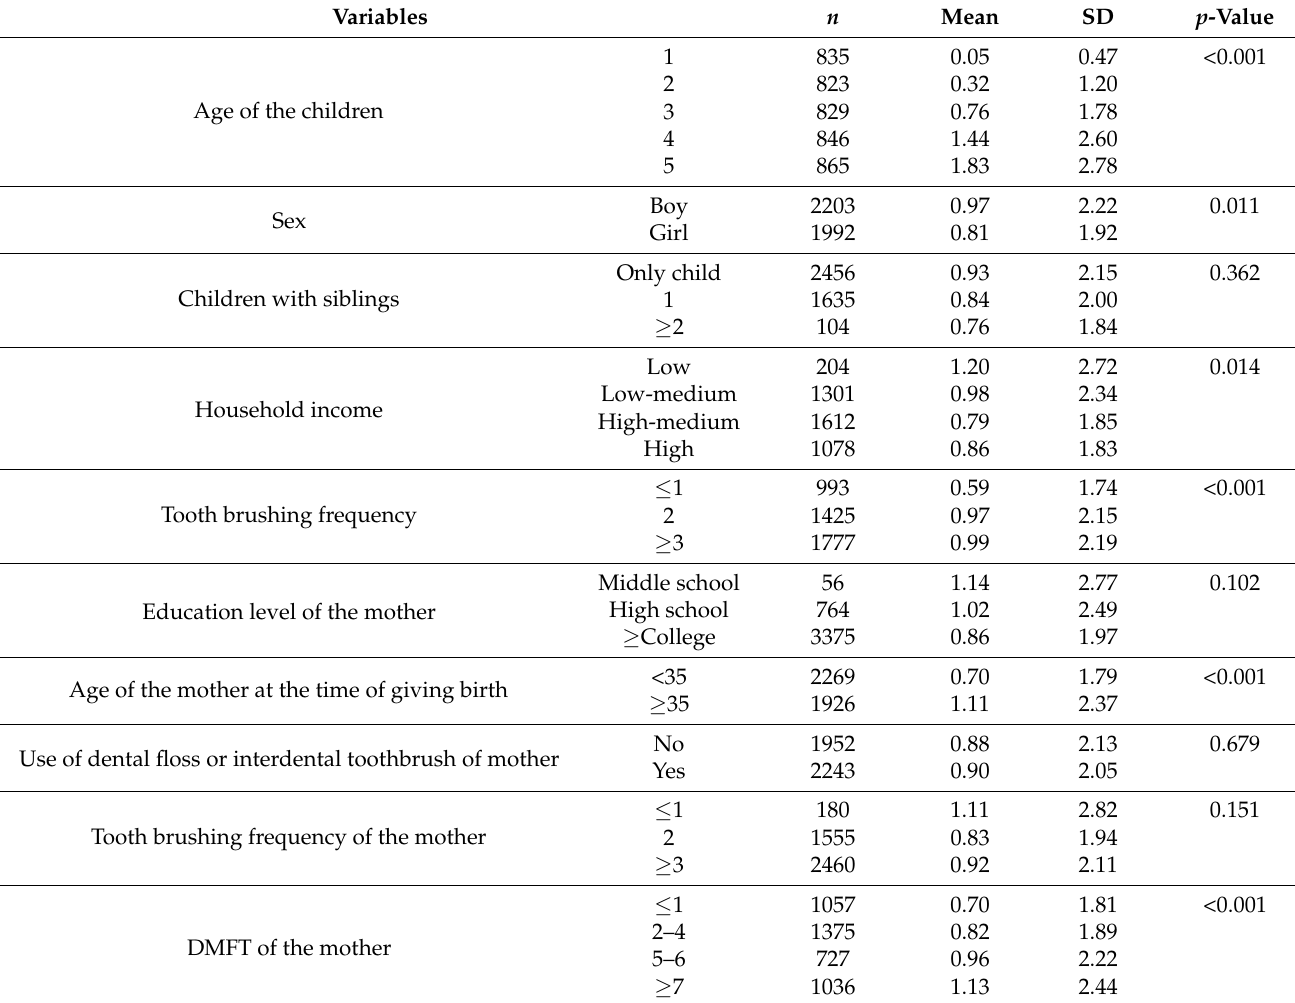
Table 2. Comparison of the dft values based on the characteristics of the participants. Variables